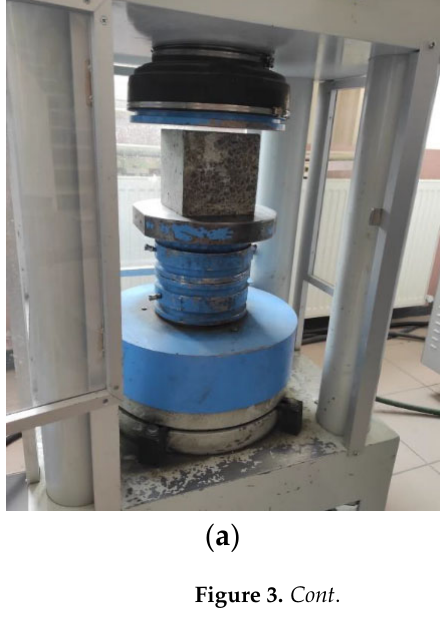
Table 2. Mix design of concrete (kg/m 3 ).